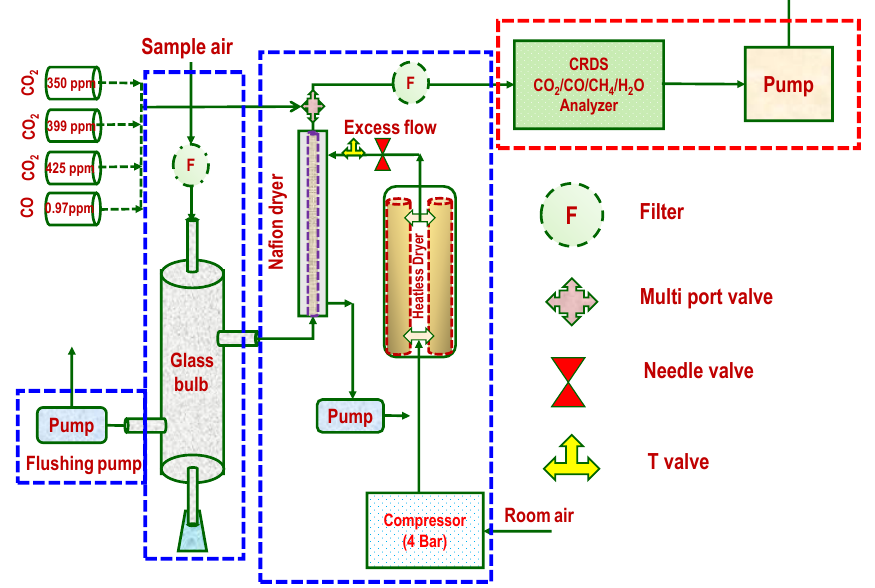
Figure 2. Schematic diagram of the experimental set-up. We additionally introduce a Nafion dryer upstream of the inlet of the instrument for removing the water vapour. Three calibration mixtures from NOAA, USA are used to calibrate CO 2 measurements and one calibration mixture from Linde, UK is used to calibrate CO measurements. The red-coloured box covers the analyser system received from the company, while two blue-coloured boxes cover the 2-stage moisture-removing systems, designed at our lab in